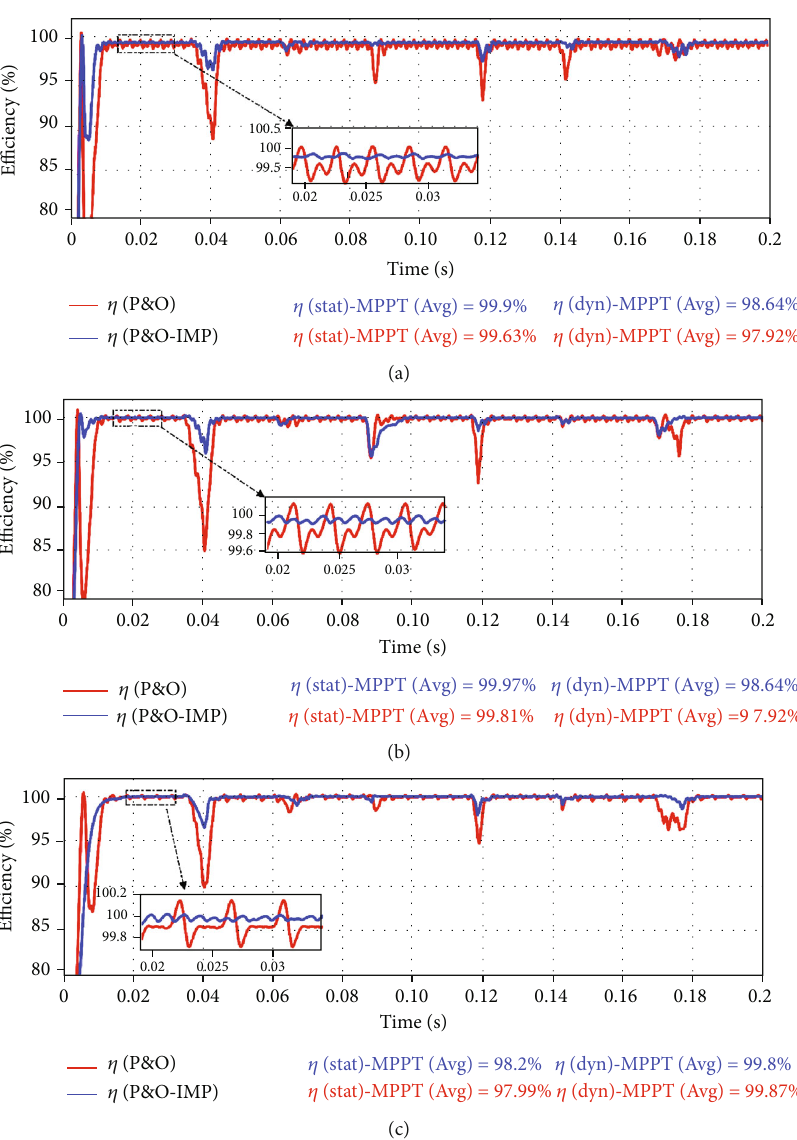
Figure 20: E ffi ciency pro fi le comparison between the P&O MPPT algorithm and the improved P&O MPPT under the scenario of temperature variation with normal solar radiation (a) 1000 W/m 2 , (b) 800W/m 2 , and (c) 600 W/m 2